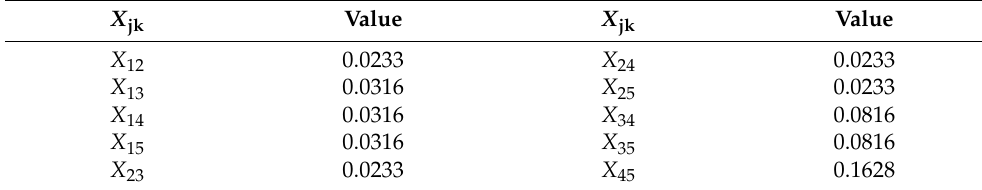
Table 6. Values for X jk .